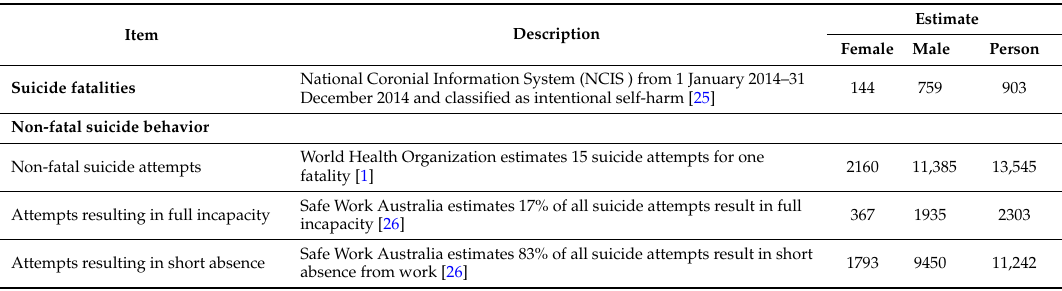
Table 3. Summary of key